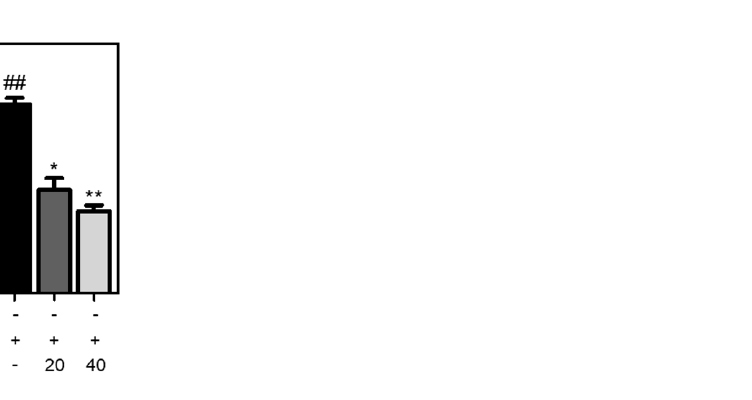
( d ) Figure 4. Expression of genes, including PCSK9 ( a ), LDLR ( b ), SREBP2 ( c ), and HNF-1 α (d) in HepG2 cells treated with fetal bovine serum (FBS) or DLPS in the presence or absence of icaritin (0, 20, 40 µM), measured using qRT-PCR. #; significant difference between cells treated with FBS and DLPS (Student’s t -test, # p < 0.05; ## p < 0.01). *; significant difference between cells treated with DLPS and compounds (Student’s t -test, * p < 0.05; *** p < 0.001). 3.6. Icaritin Significantly Suppressed the Extracellular PCSK9 Level Increased by DLPS in HepG2 Cells Following secretion from the Golgi apparatus, a mature form of PCSK9 binds to LDLR, which is internalized and then transported with LDLR to the lysosomes for deg- radation [23]. In the present study, extracellular PCSK9 was measured in HepG2 cell